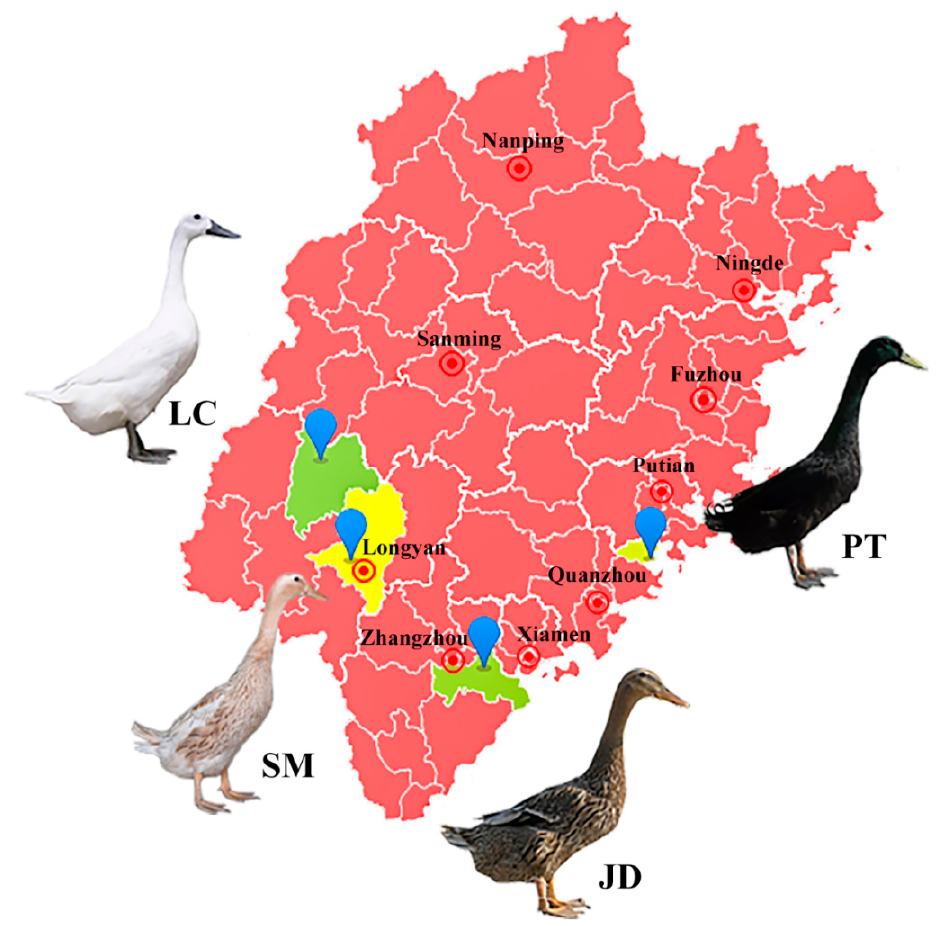
Figure 1. Location of the producing areas of four indigenous duck breeds in Fujian Province. The map was generated by DataMap 6.4 (Global Tone Communication Technology Co. Ltd., Qingdao, China) which is a plug-in for Microsoft Excel 2019 (Microsoft Corporation, Washington, DC, USA). Abbreviations: LC, Liancheng white duck; SM, Shanma duck; JD, Jinding duck; PT, Putian black